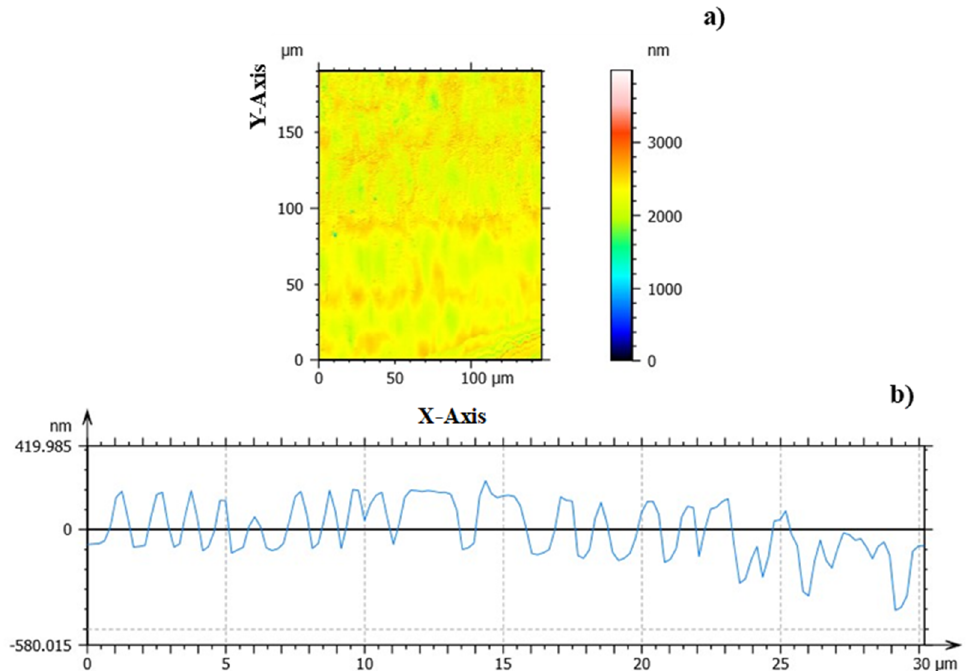
Figure 7. Measured profile of the trimmed side surface of the CVD-diamond coating using white-light interferometry. ( a ) Two-dimensional surface angulation of the trimmed diamond coating, and ( b ) lateral surface profile of the nano-textured ripples on the trimmed surface.